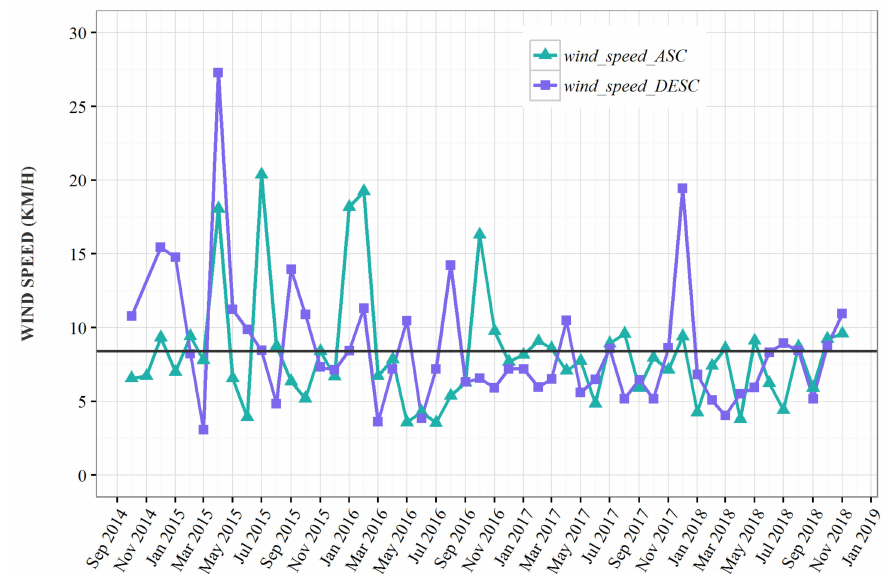
Figure 12. Average wind speed time-series between October 2014 and November 2018. The average wind speed was calculated for the days of Sentinel-1 image acquisitions (ascending and descending paths separately). In months where the wind threshold was exceeded for all pixels at all acquisitions, wind speed was calculated without applying the wind filtering. For the rest, wind speed was calculated by applying the wind filtering because we wanted the average wind speed only for the unmasked pixels. The black line shows the average wind speed of 8.39 km /